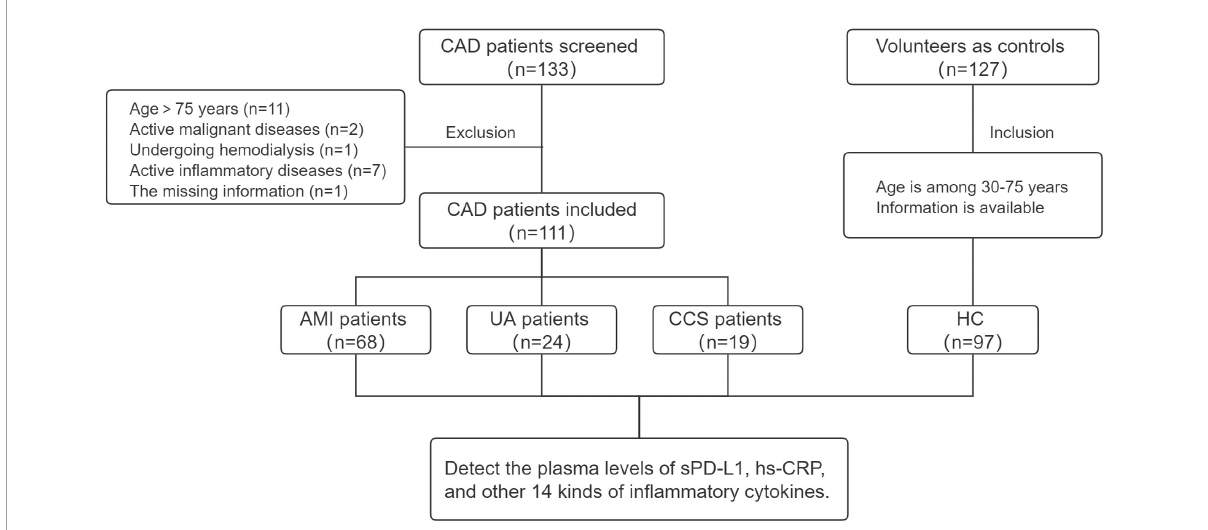
FIGURE1 Study flow chart. CAD, coronary artery disease; AMI, acute myocardial infarction; UA, unstable angina; CCS, chronic coronary syndrome; HC, healthy